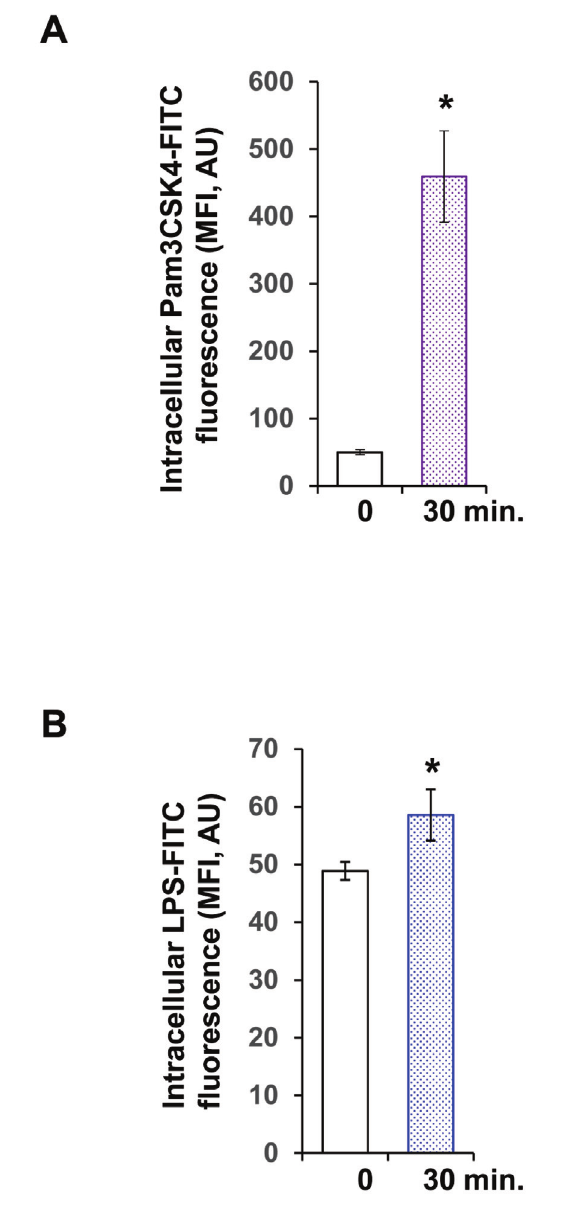
Fig. 5 Intracellularuptake of fl uorophore-labeledTLRligands.Theuptake of FITC-labeled Pam3CSK4 (A) or LPS (B) in WP was measured after 30minute of stimulation. The detection of intracellular Alexa Fluor 488 fl uorescence was performed by fl ow cytometry, after quenching of extracellular fl uorescence with Trypan blue. Data are shown as mean MFI (cid:3) SEM; n ¼ 6; (cid:4) p < 0.05. LPS, lipopolysaccharides; SEM, standard error of mean; TLR, toll-like receptor; WP, washed platelets.